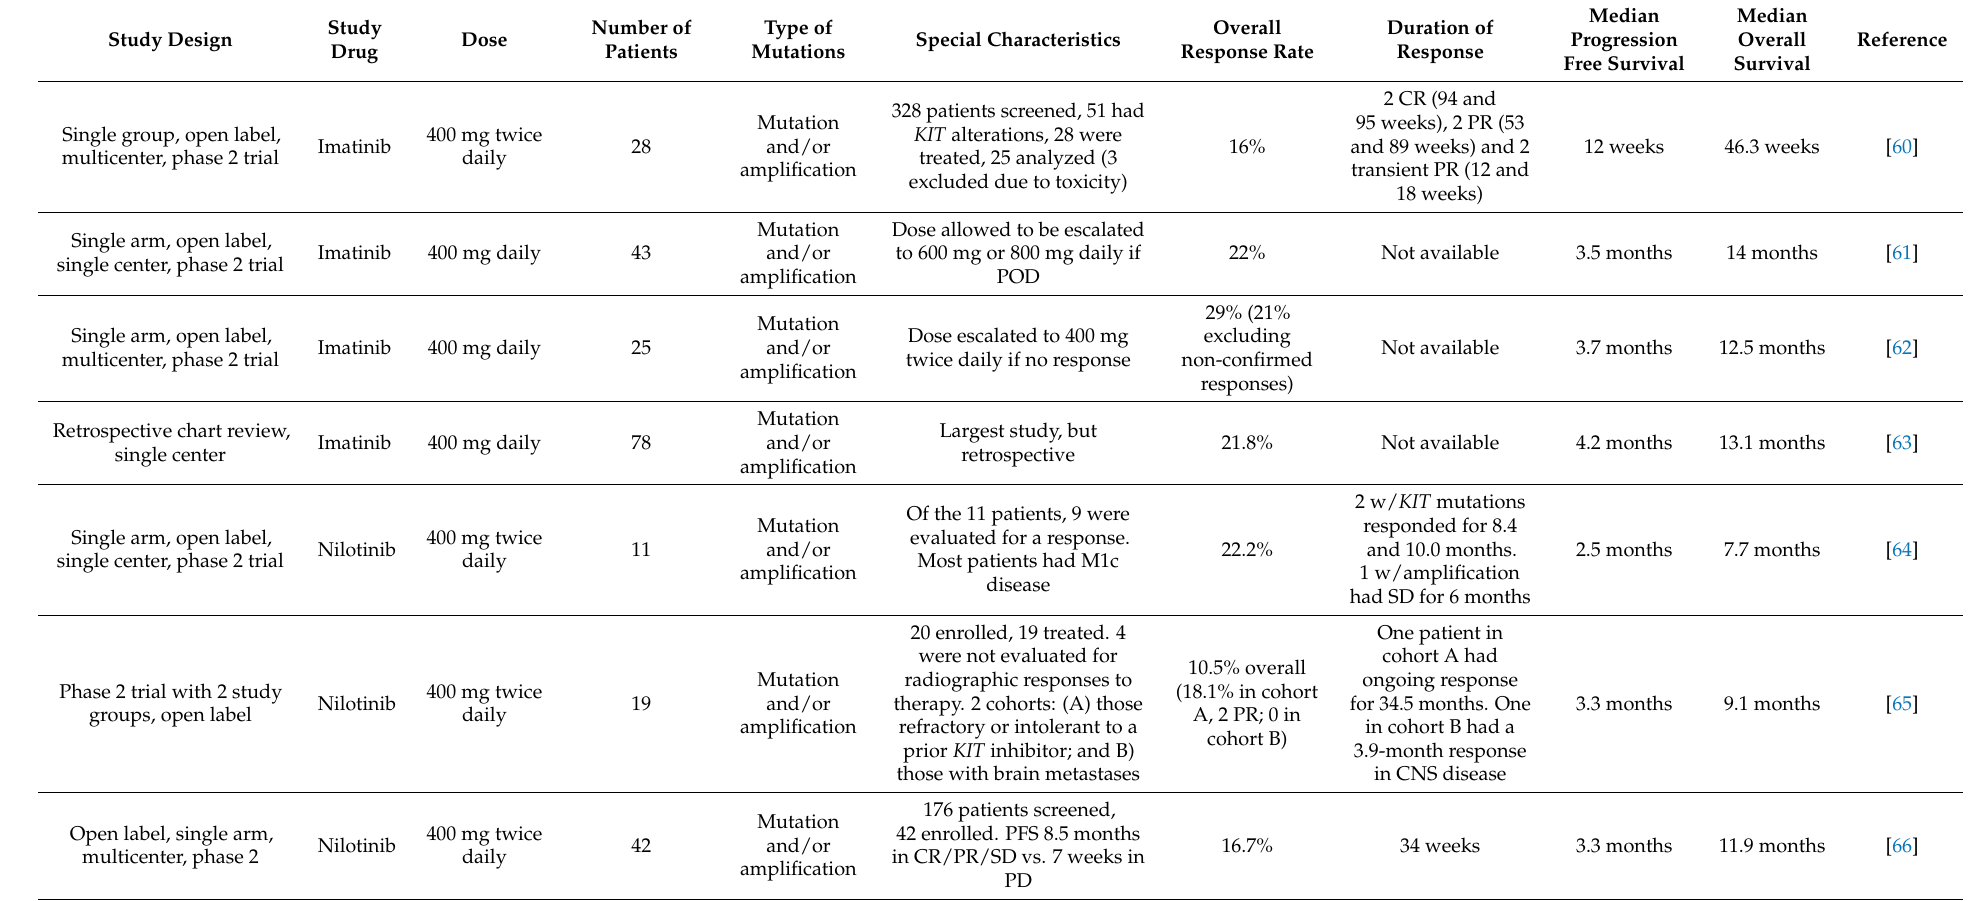
Table 1. Clinical trials and retrospective studies of targeted therapy in c-KIT mutant